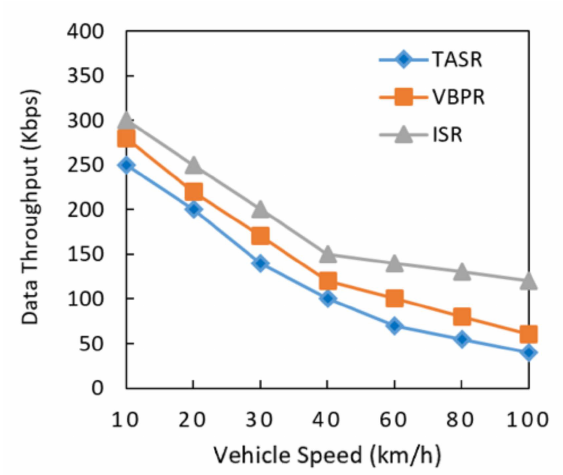
Figure 11. Comparison of data throughput with increasing vehicle speed.